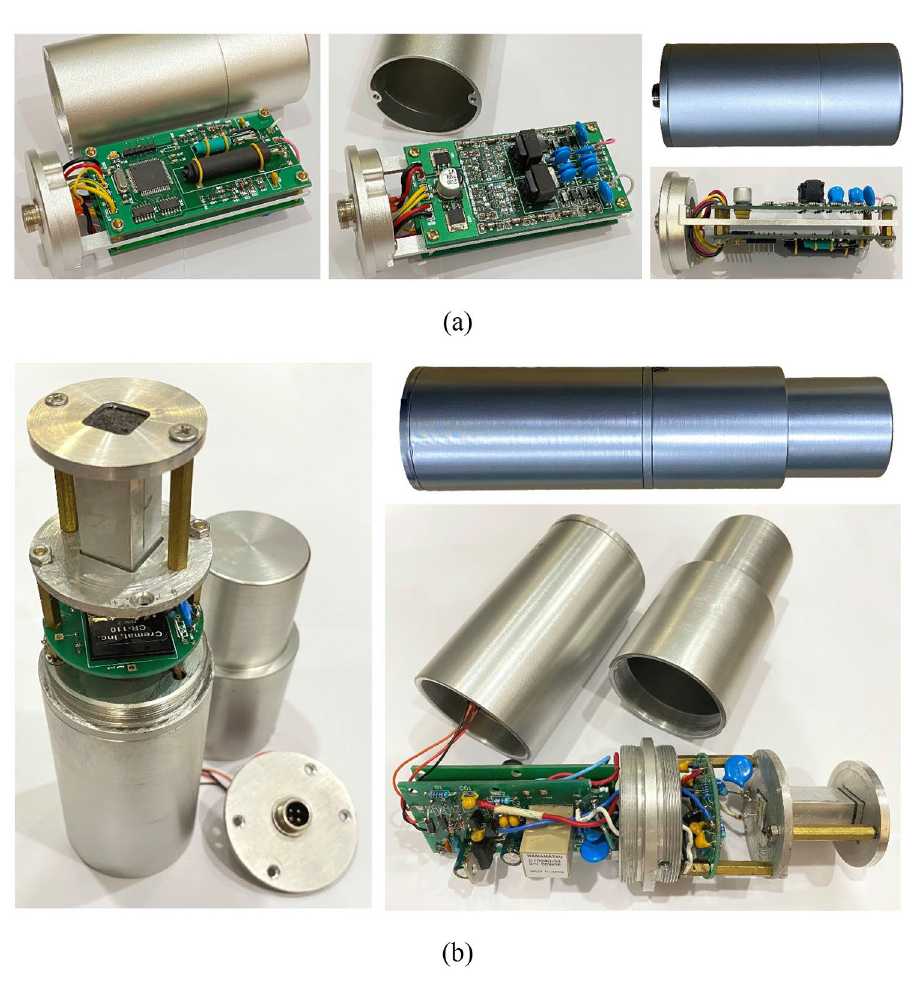
Figure 4. Detector prototypes: ( a ) detector module with GM tubes and ( b ) detector module with the CsI(Tl)